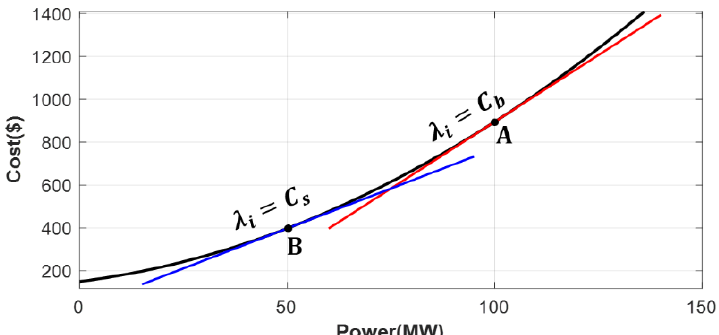
Figure 3. Typical generator fuel cost. 𝐶 𝑏 shows the incremental cost when the power is being pur- chased from the utility (point A). 𝐶 𝑠 shows the incremental cost when the power is sold to the utility (point B). The power mismatch is used to select either of these operations. However, all DDGs inside the microgrid must match either of these rates (A or B) at the optimal point.